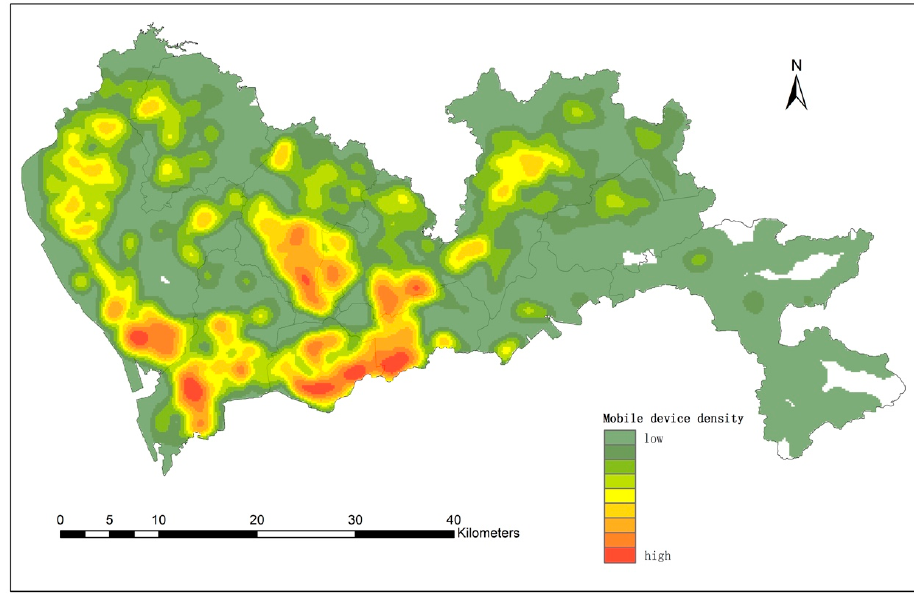
Figure 1. The distribution of active mobile devices during night time in Shenzhen (September, 2018).